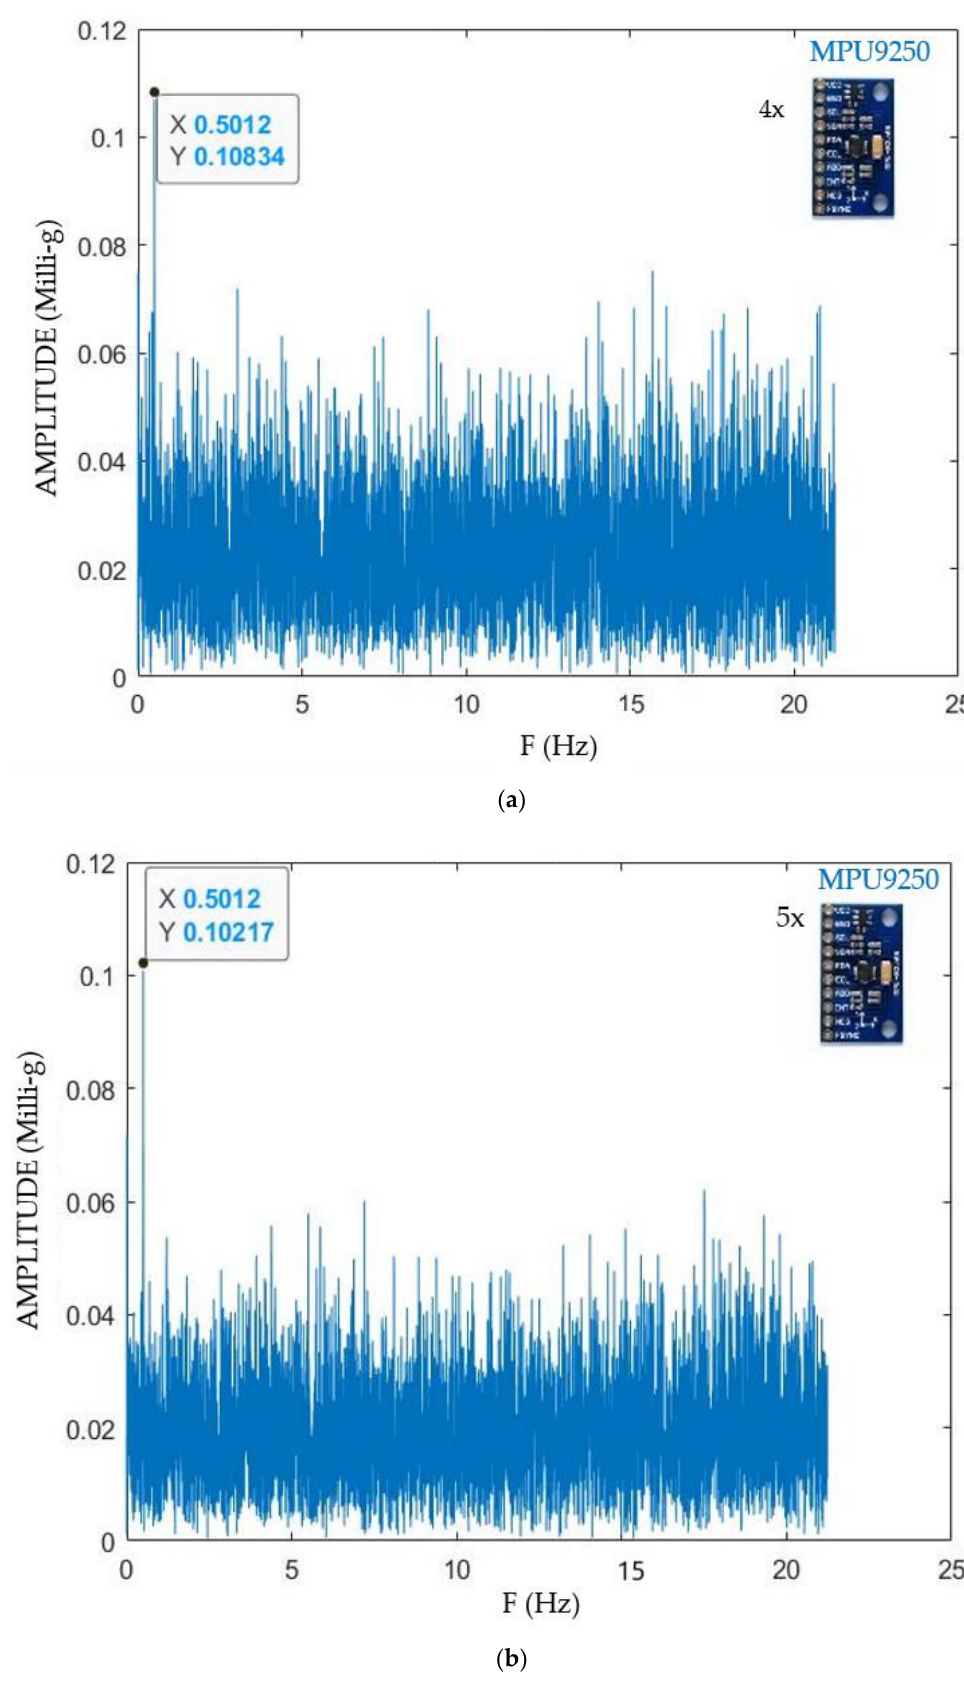
Figure 6. FFT data process for 0.5 Hz experiment errors for four sensors ( a ) and five sensors ( b ).